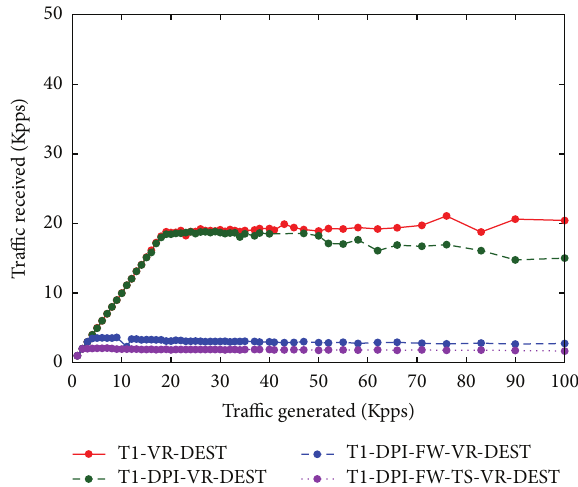
Figure 16: Received versus generated packet rate for one tenant (T1) when four tenants are active, with 1500 -byte IP packet size and different levels of VNF chaining as per Figure 7. DPI: deep packet inspection; FW: firewall/NAT; TS: traffic shaper; VR: virtual router; DEST: